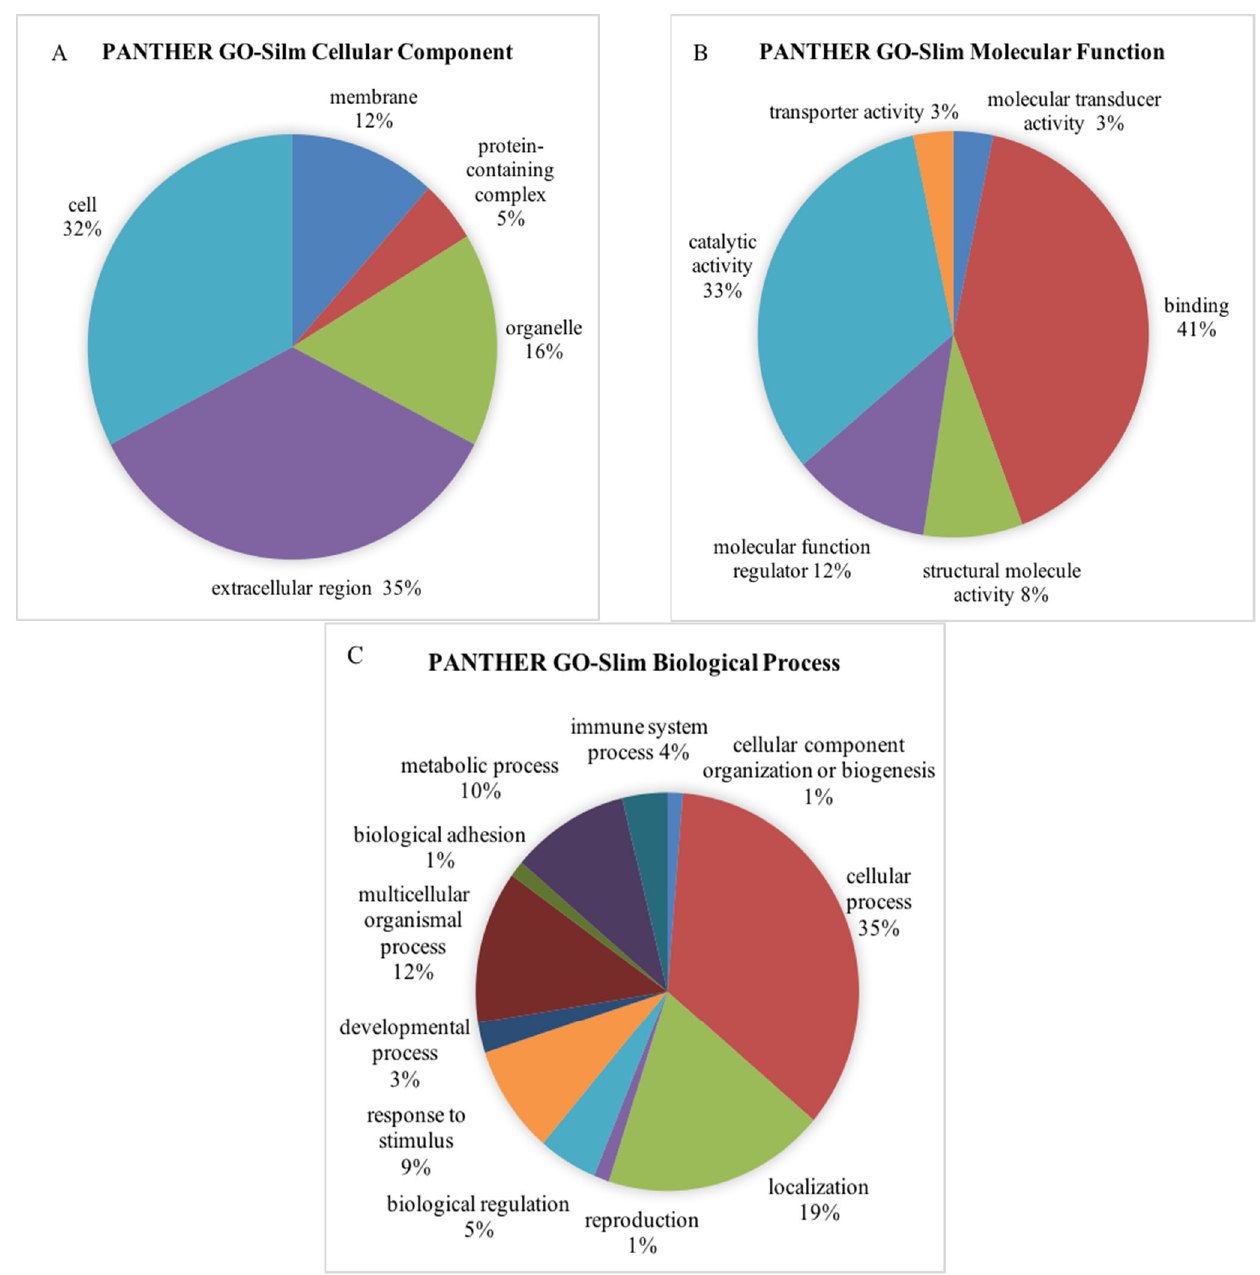
Figure 2. PANTHER GO ‐ Slim annotation of the differentially expressed proteins. ( A ) The PANTHER GO ‐ Slim Cellular Component. ( B ) The PANTHER GO ‐ Slim Molecular Function. ( C ) The PANTHER GO ‐ Slim Biological Process.